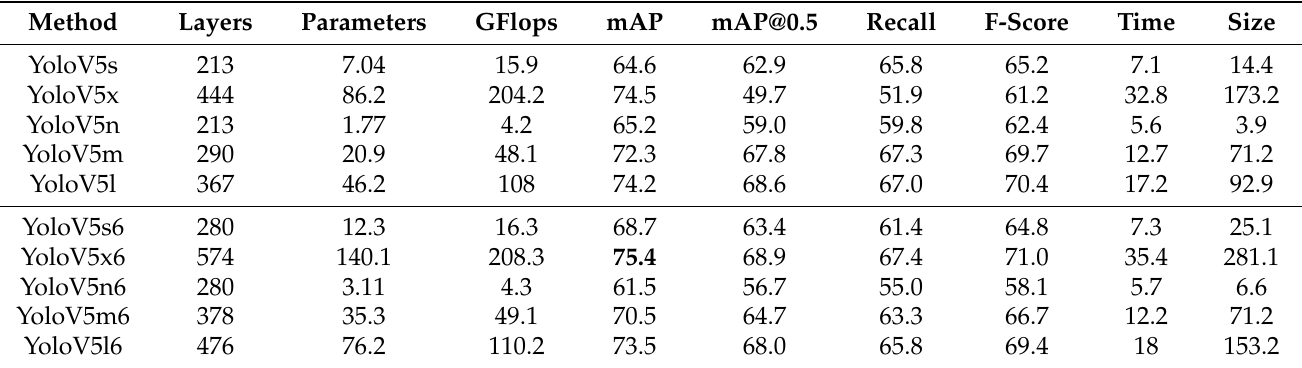
Table 3. Comparison among different YoloV5 architectures. The first main comparison is between YoloV5-P5 and YoloV5-P6. The parameters are measured in millions (M), average precision is measured in %, training time is measured in hours, and model size is measured in MB. In the names of YoloV5, the subscripts “s”, “n”, “m”, “l”, and “x” refer to small, nano, medium, large, and extra-large network